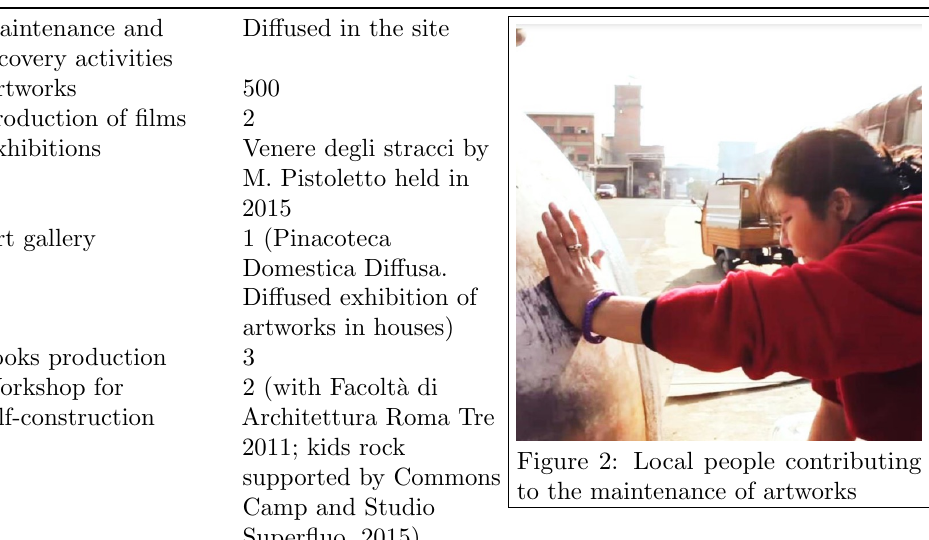
Figure 2: Local people contributing to the maintenance